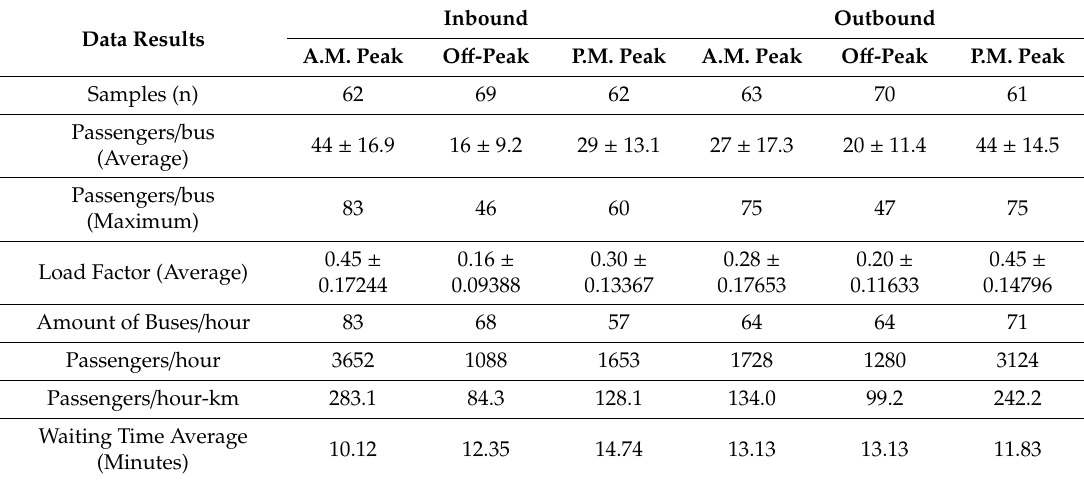
Table 2. The Field Survey Results of Travel Demand with Di ff erent Time